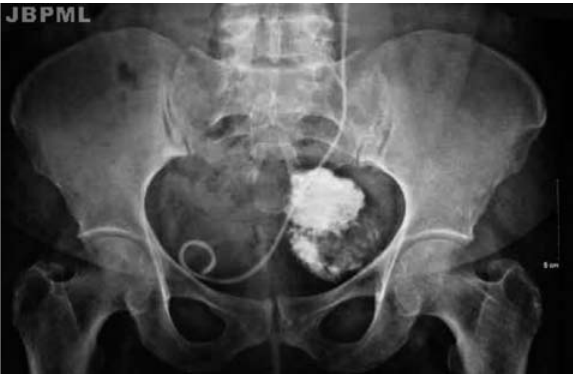
Figure 1 – Radiograph of the pelvis. A calcified mass with ovoid shape in left pelvis